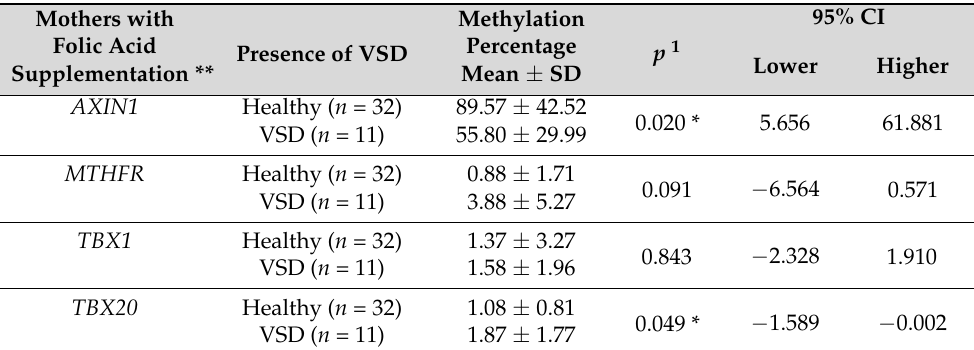
Table 6. Association of maternal intake of folic acid supplements with the methylation percentage of genes associated with VSD in children. 95% CIMothers with Methylation Folic Acid Percentage p 1 Presence of VSD Lower Higher Supplementation ** Mean ± SD AXIN1 Healthy ( n = 32) 89.57 ± 42.52 0.020 * 5.656 61.881 VSD ( n = 11) 55.80 ± 29.99 MTHFR Healthy ( n = 32) 0.88 ± 1.71 0.091 −